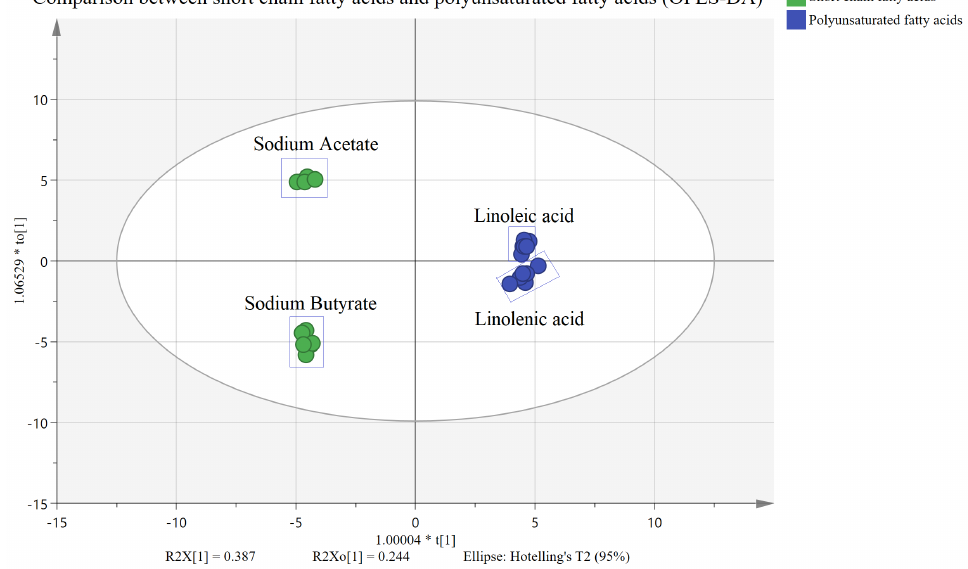
Figure 9. OPLS-DA plots between short-chain and polyunsaturated fatty acids.